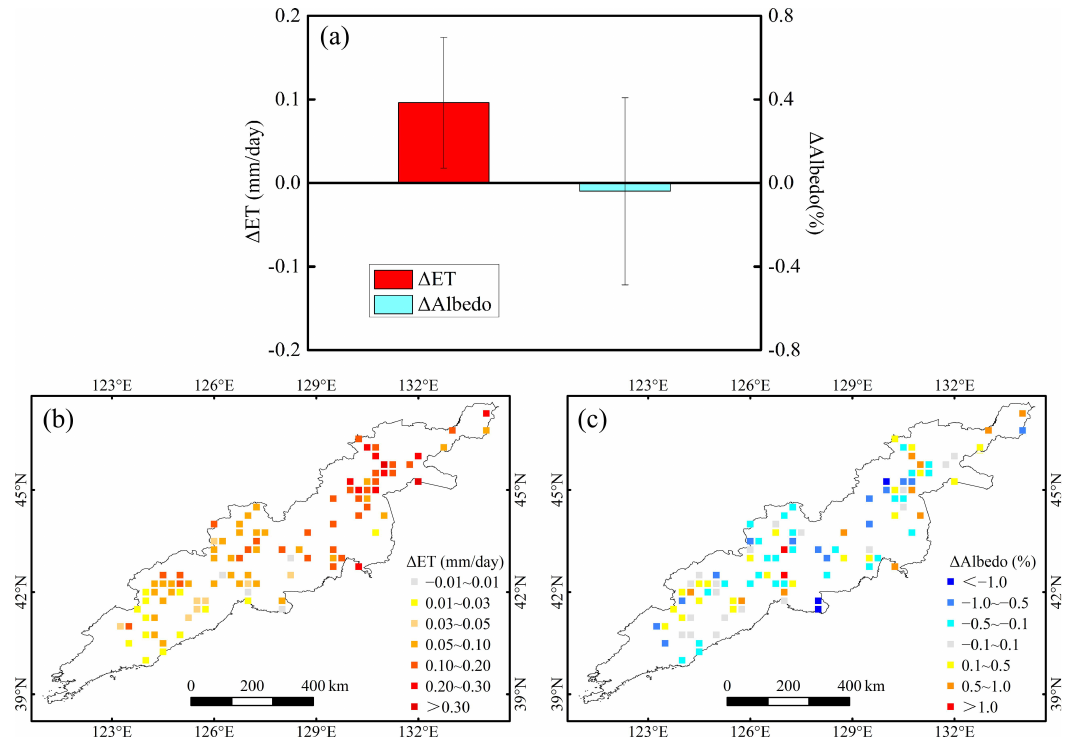
Figure 5. Average value ( a ) and spatial distribution of differences in summer evapotranspiration ( ∆ ET, mm/day) ( b ) and albedo ( ∆ Albedo, %) ( c ) between forest and open land in Changbai Mountain from 2003 to 2017.